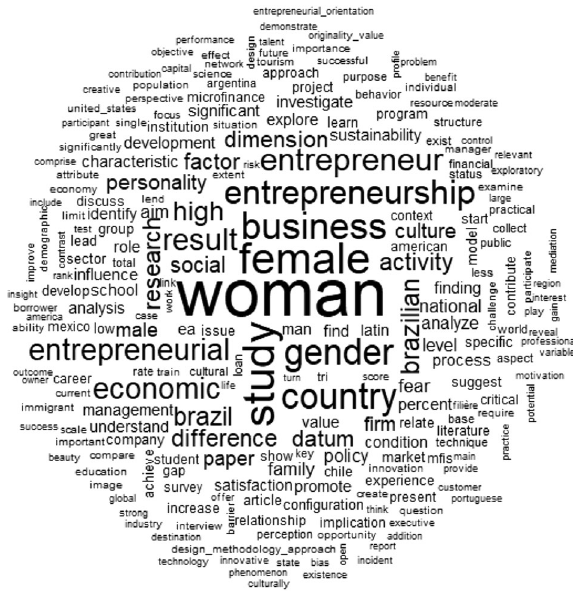
Fig. 2 Word Cloud of absolute frequency of words in papers published in